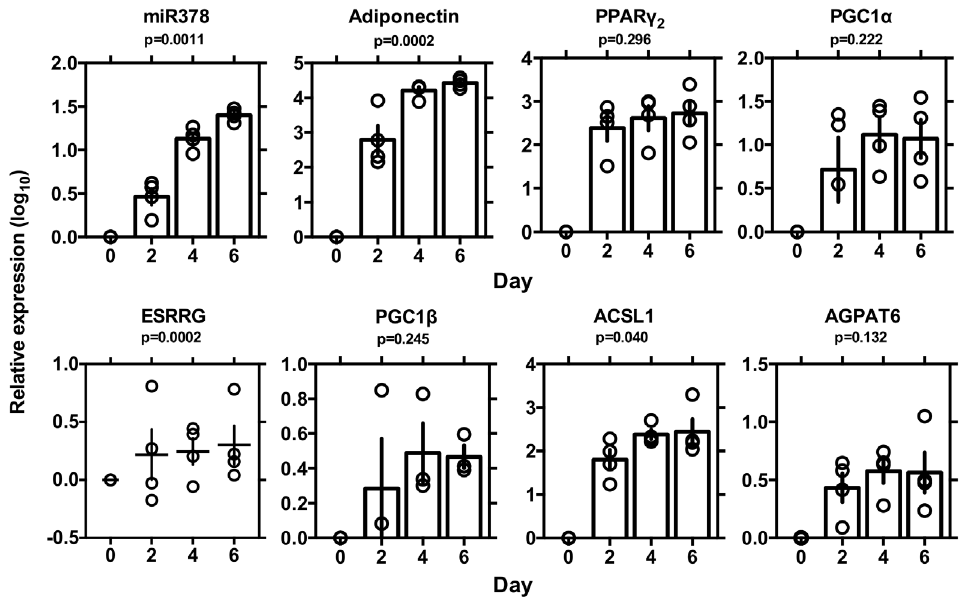
Figure 2. Levels of miRNA-378, adiponectin, PPAR c 2 , PGC1 a , ESRRG, PGC1 b , ACSL1 and AGPAT6 during differentiation of 3T3-L1 adipocyte cells. The mouse 3T3-L1 cell line was cultured in DMEM/10% FBS and dispensed into 12-well plates (day 2) before induction of adipose differentiation. Once the cells had grown confluently, they were stimulated with insulin (10 m g/mL) dexamethasone (1 nM), and IBMX (500 m M) for 2 days (days 0–2), and the medium was changed every 2 days. At days 0, 2, and 6, RNA was extracted and levels of miRNA-378 and mRNAs of adiponectin, ACSL1, GPAT6, PPAR c 2, PGC1 a , PGC1 b , and ESRRG were evaluated by qPCR. Expression levels normalized to those of b -actin were log- transformed. Individual values are shown with mean 6 SE